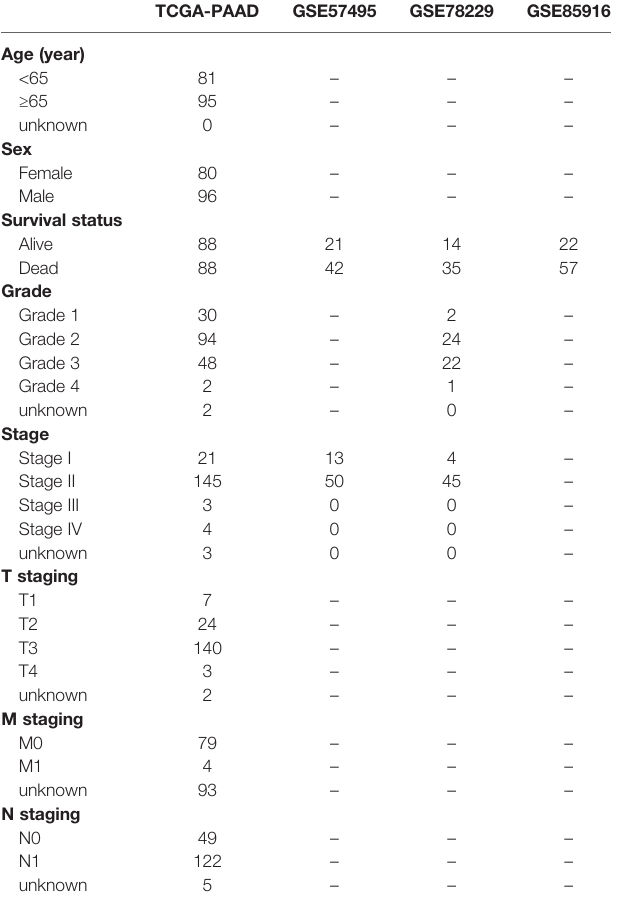
TABLE 1 | Clinical data of PAAD cohort from TCGA, GSE57495, GSE78229,